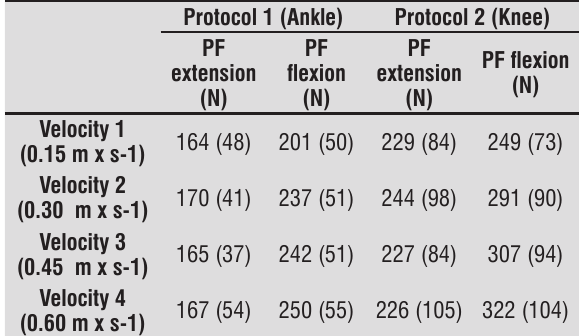
Table 1 - Descriptive statistics (mean ± SD) of the Peak Force variable (PF) during day 2 evaluations